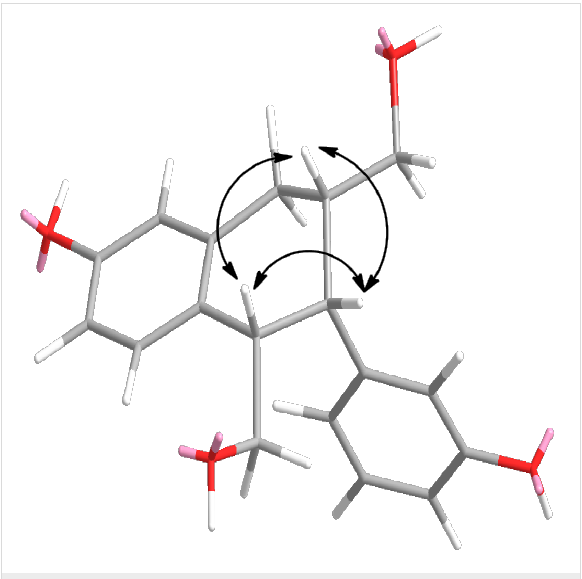
Figure 3: Key NOESY correlations ( 1 H ↔ 1 H) for trogopterin C (com- pound 3 ) identified in the ChemDraw 3D MM2-minimized model.